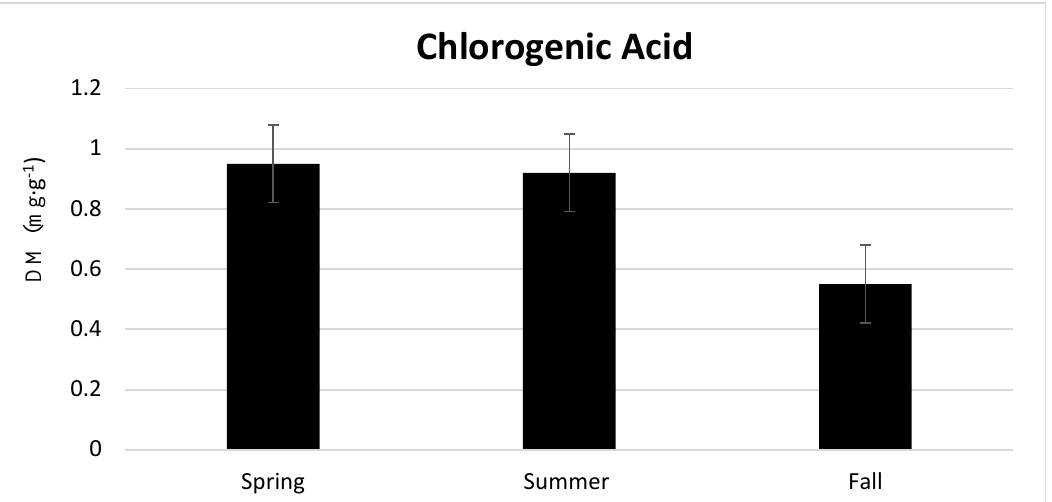
Figure 6. The effect of growing season on greenhouse lettuce chlorogenic acid content. The standard error of the mean was: Leaf DM ± 0.05. Different letters are significantly different at P ≤ 0.05 according to Tukey’s honest significant difference test.